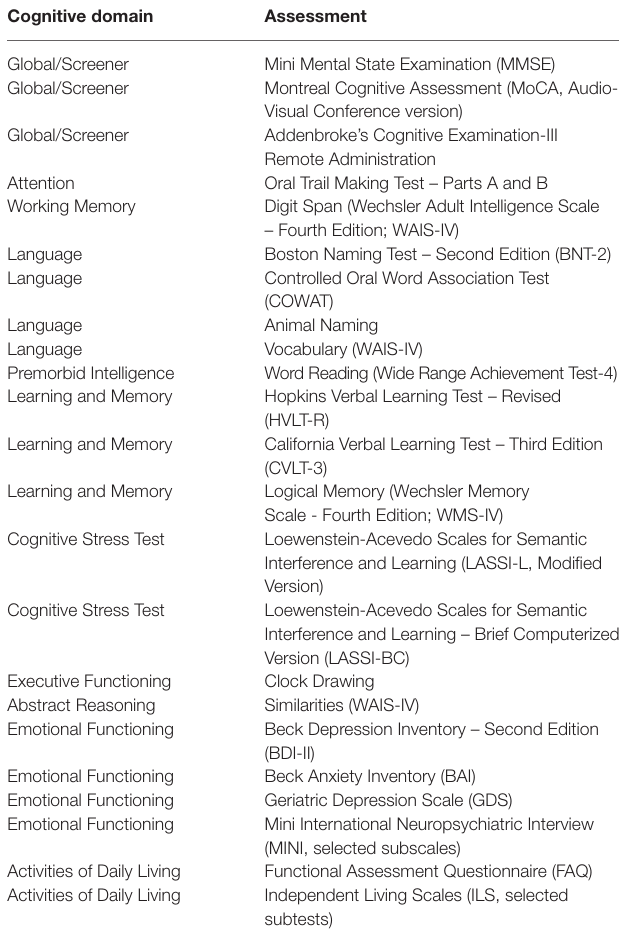
TABLE 1 | Potential teleneuropsychological